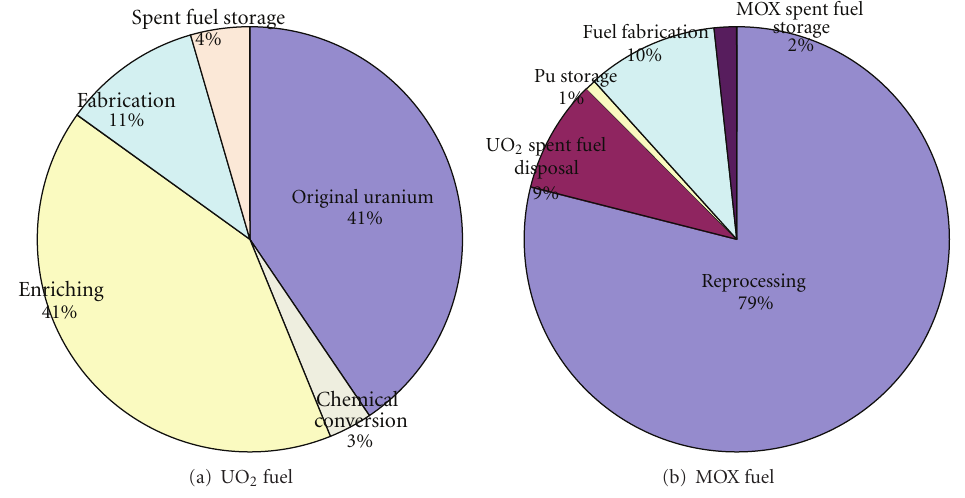
Figure 7: The cost compositions of UO 2 and MOX fuels.